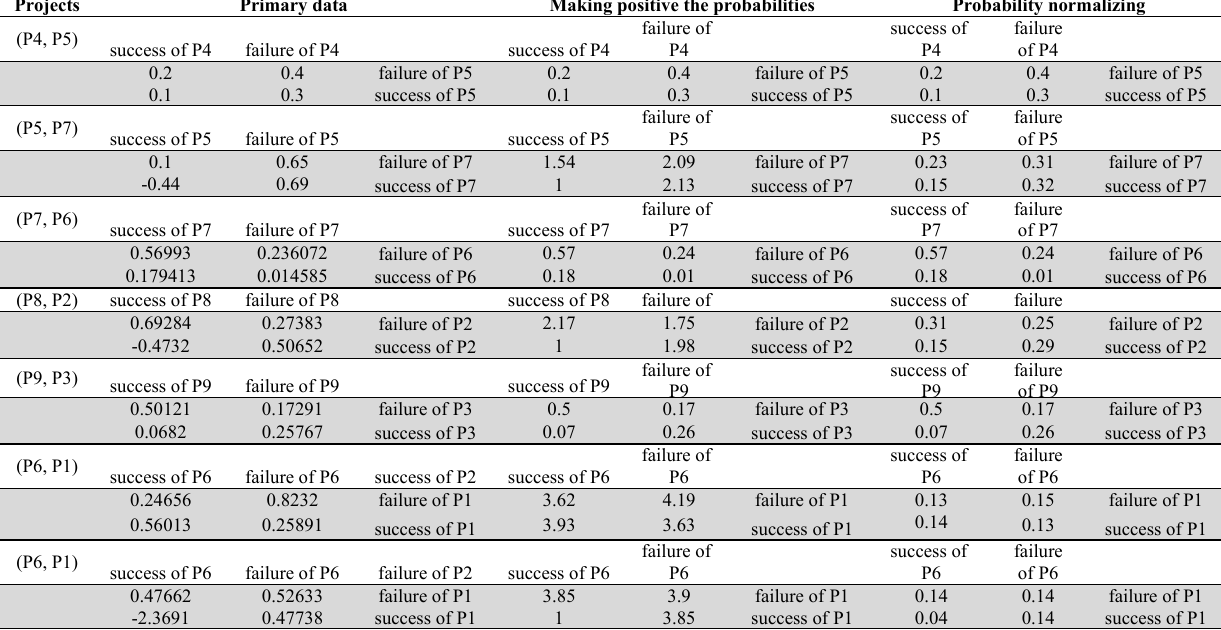
Calculation of projects success joint probability distribution functions caused by technical interdependencies Projects